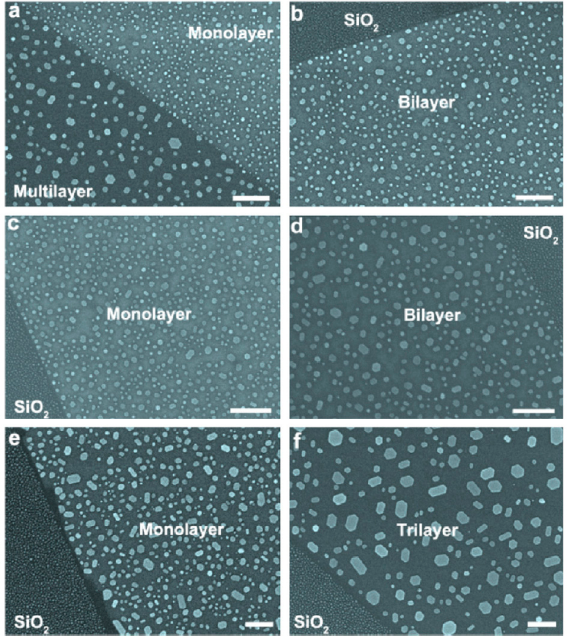
Figure 24. Scanning Electron Microscopy images showing the effects of the starting thickness of the deposited Au film on the shape of the resulting NPs after the annealing process at 600 °C for 2 h. Scale bar: 200 nm. ( a , b ) 1.0 nm thick Au; ( c , d ) 1.5 nm thick Au; ( e , f ) 2.0 nm thick Au. It is obvious to find that with the increase of Au film thickness, the modulation becomes less effective. Reproduced from Reference [68] with permission from Elsevier.